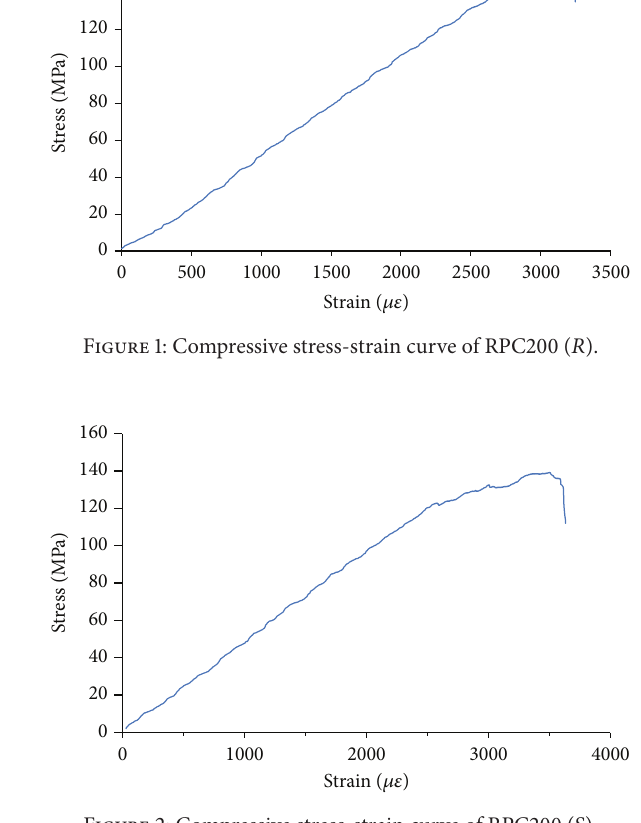
Figure 2: Compressive stress-strain curve of RPC200 ( 𝑆